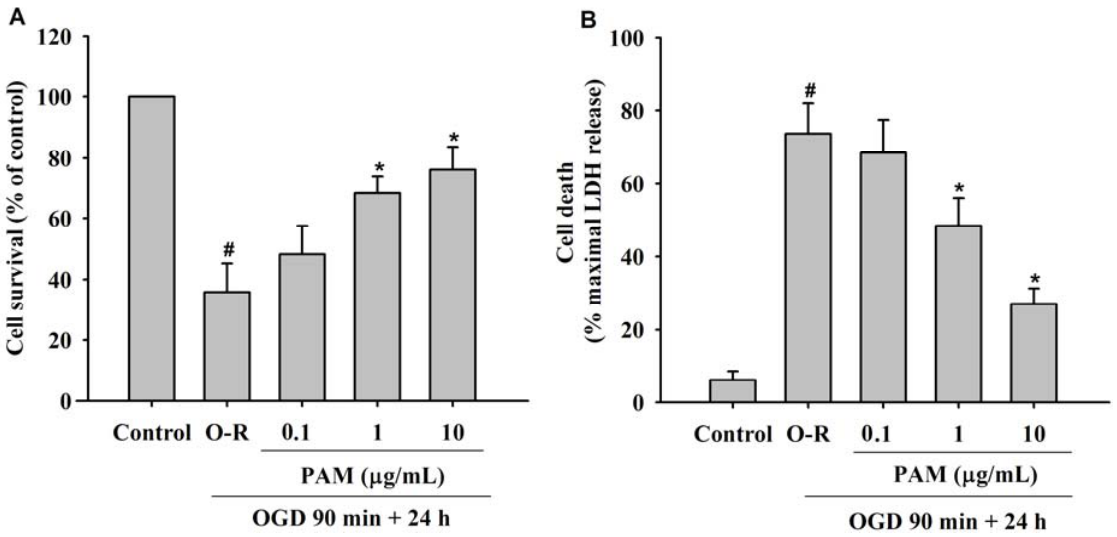
Figure 1. Effects of PAM on cell viability of primary rat cortical cultures. Cell cultures were treated with different concentration of PAM at the start of OGD until the end of reoxygenation. ( A ) Quantitative analysis of cell survival rate was detected by MTT assay; ( B ) Culture supernatants were collected and assayed for LDH with commercial LDH kit. Data are mean ± SD from three independent experiments. The results were compared using ANOVA followed by Fisher’s PLSD test. # P < 0.05 vs. control group, * P < 0.05